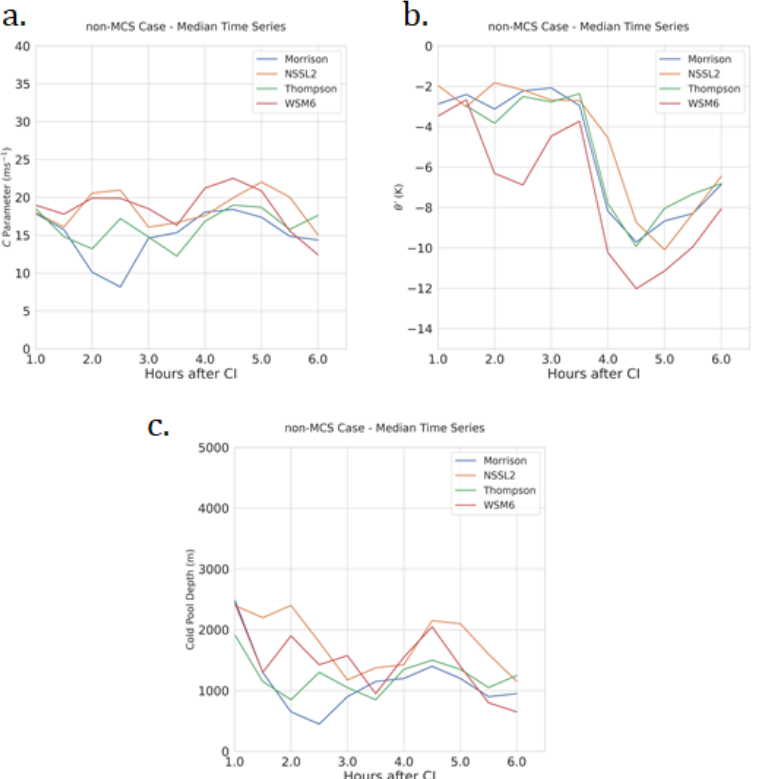
Figure 9. As in Figure 8, but for the 8 August 2016 non-MCS event.